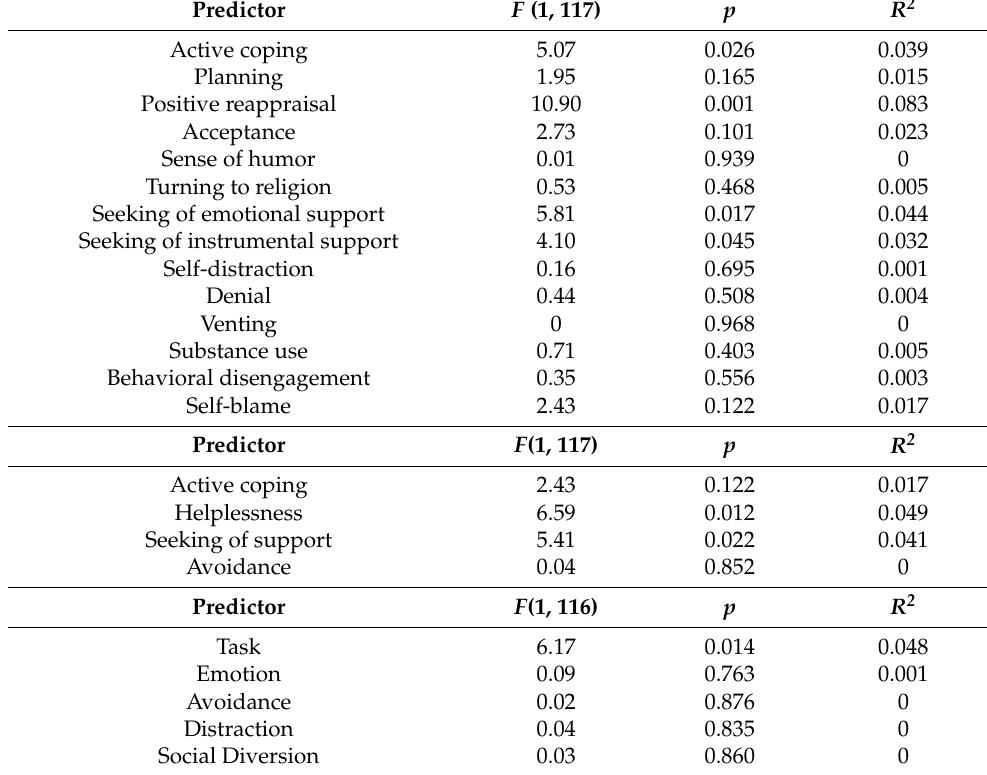
Table A1. The influence of patients’ age on coping styles and strategies and patients’